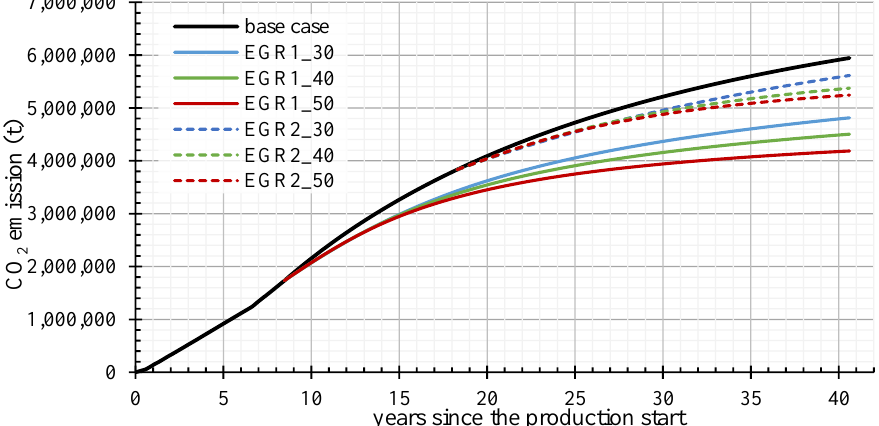
Figure 4. Comparison of CO 2 emissions in the base case and each EGR scenario.